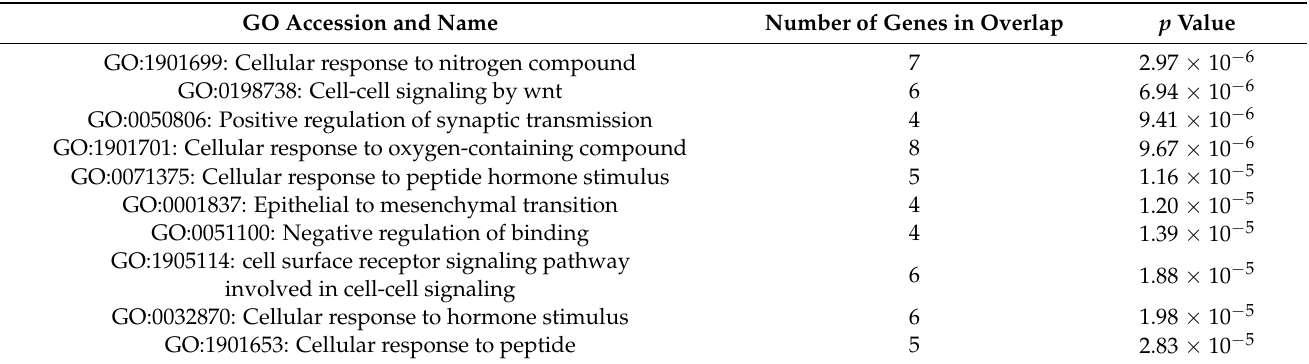
Table 3. Enriched GO terms from GO analysis of the miRNA-targeted mRNA gene set. The number of genes (targets of miRNAs sequestered by circRNAs) that correspond to each GO term and the enriched p value are